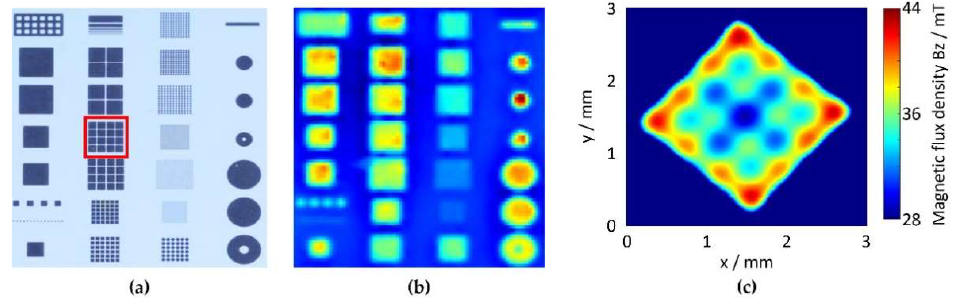
Figure 5. ( a ) Microscope image of NdFeB microstructures embedded in a silicon substrate. ( b ) Scan of the same area with a 3D Hall sensor. The color code represents magnetic flux perpendicular to the substrate surface. ( c ) Detailed scan of the 4 × 4 array marked in red in ( a ), consisting of (500 × 500) µm 2 magnets. The vertical distance between the Hall sensor and the substrate surface was 120 µm.